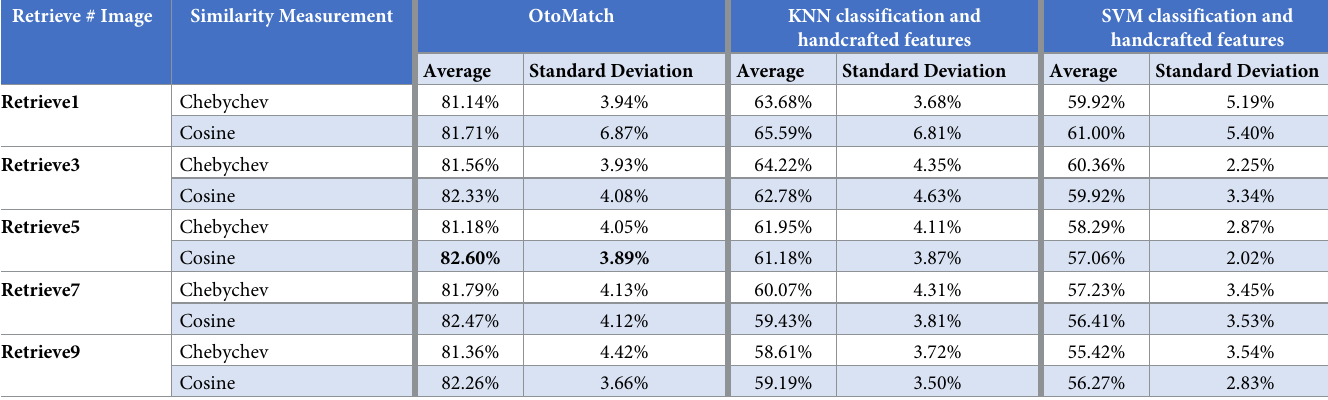
Table 6. Comparison of image retrieval methods. Average accuracies and standard deviations of 1, 3, 5, 7, and 9 content based image retrievals for 10-fold with Oto- Match, traditional KNN, and SVM classifications using handcrafted features. Retrieve #